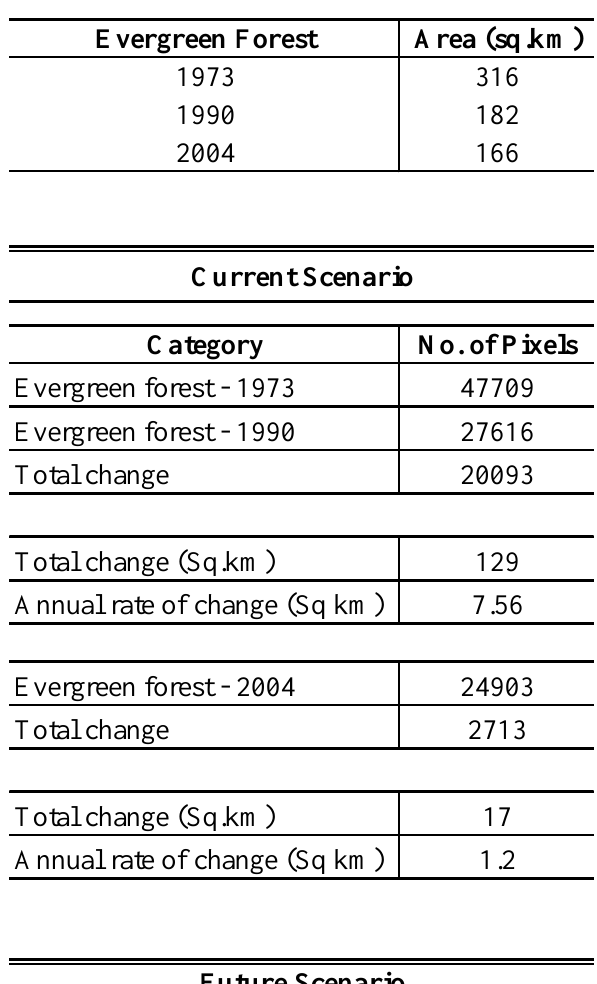
Table 3. Current and future scenarios for the evergreen forests loss observed in KMTR of South Western Ghats, Tamil Nadu